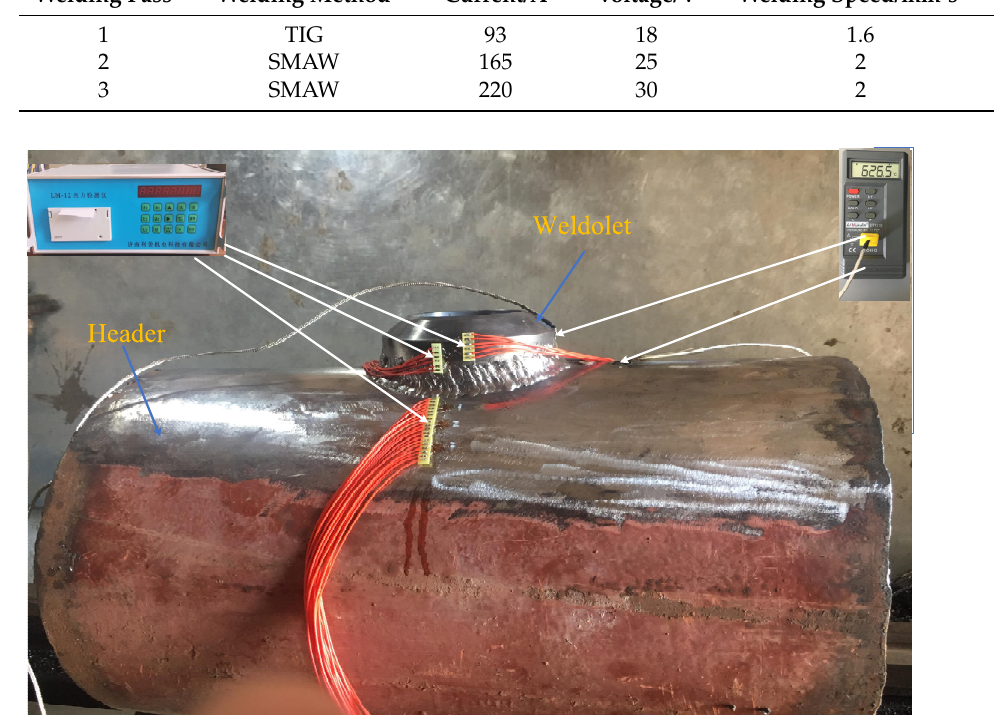
Figure 2. Experiment weld set-up for the